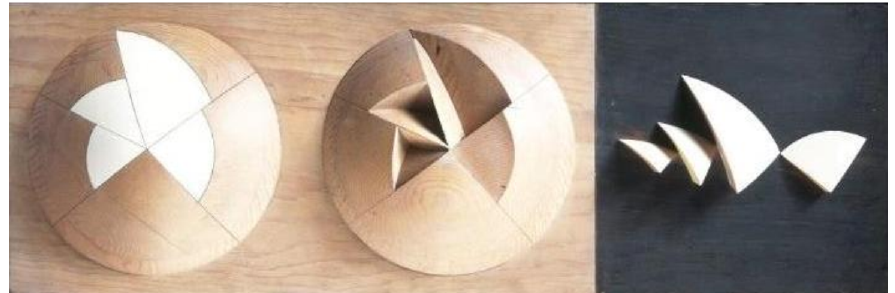
Figure 9. Wooden model with the deck pieces taken as surfaces of the same sphere (picture by MoMa, 1961; www.moma.org; last accessed 2 December